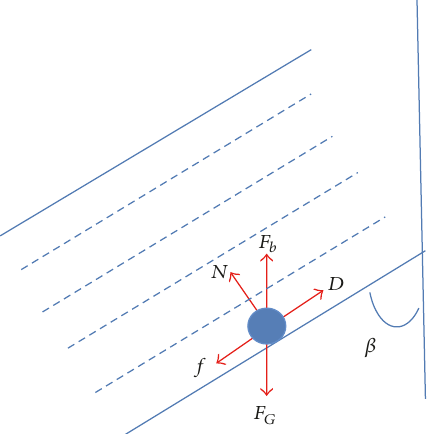
Figure 1: Force balance of droplet in directional well, where 𝛽 is the deviation angle, degrees, with 𝛽 = 90 ∘ which represents the horizontal well; 𝐷 is the drag force of airstream on droplet, N; 𝐹 𝐺 is the droplet gravity, N; 𝑓 is the wall friction to the droplet, N; 𝑁 is the bracing force, N; 𝐹 𝑏 is the buoyancy force,